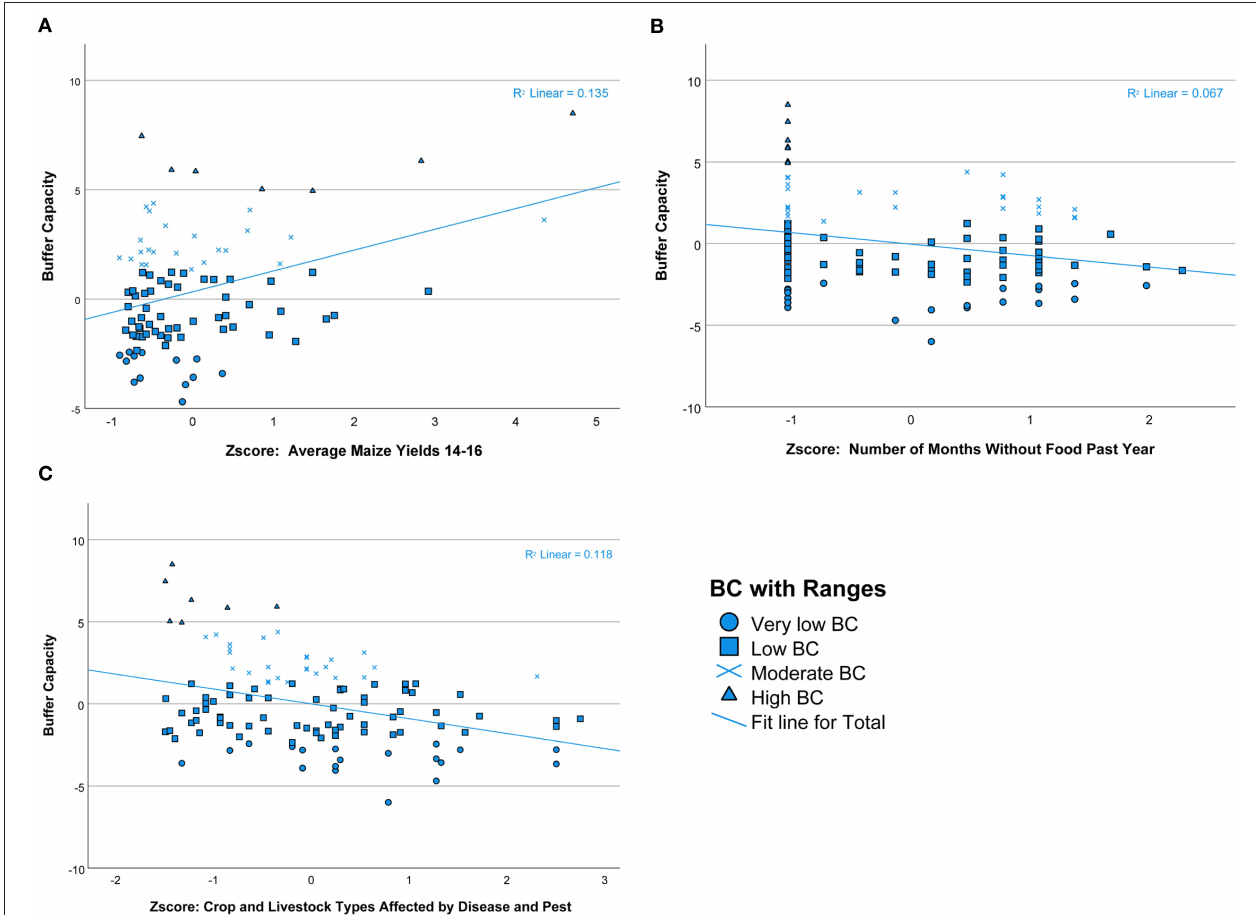
FIGURE 7 | Scatterplots, BC and (A) maize yields 2014–2016, (B) number of months without food past 12 months and (C) crop and livestock types affected by disease and pest.